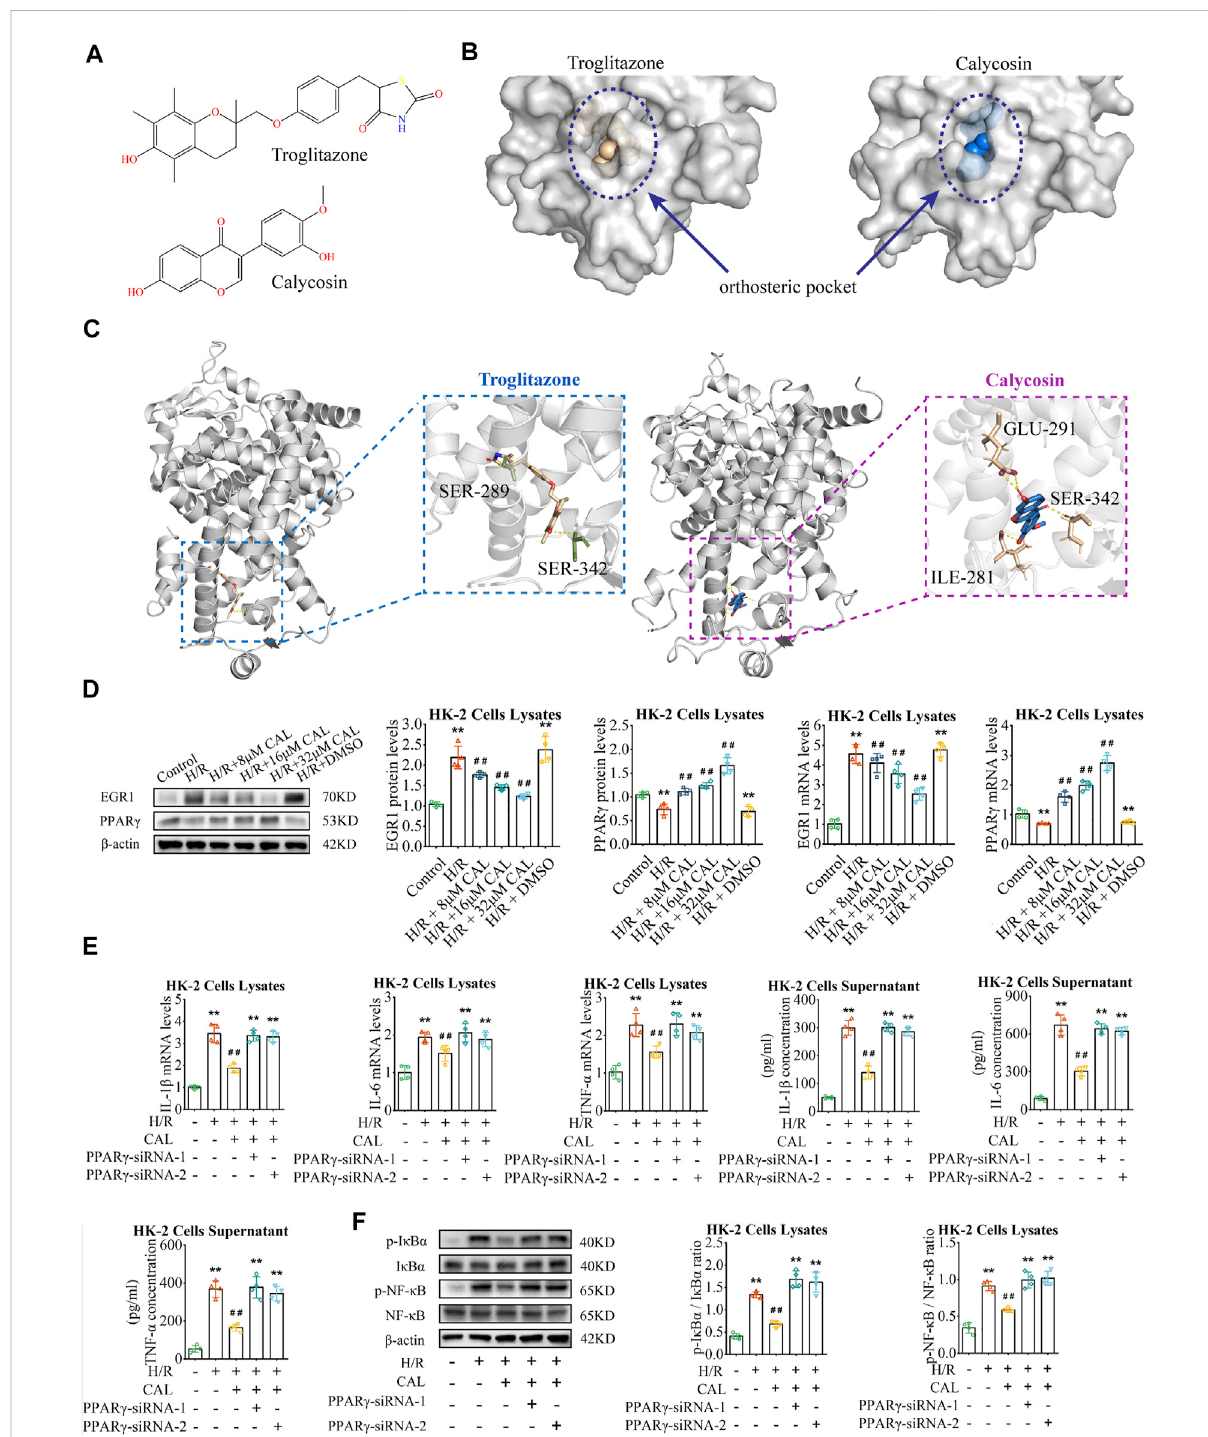
FIGURE 5 CAL inhibited in fl ammation via PPAR γ /EGR1. (A) Chemical structure of troglitazone and CAL. (B) Structure of PPAR γ revealed troglitazone and CAL is located in the orthosteric pocket of PPAR γ . Troglitazone and CAL are shown as the spheres structure, and PPAR γ is shown as the surfaces structure. (C) Troglitazone and CAL (ligand) bound to PPAR γ (receptor) via hydrogen bonds. Ligand are shown as the stick structure, and PPAR γ is shownasthecartoonstructure.Hydrogenbondsareshownasdottedlines(yellow).ILE,isoleucine;SER,serine;GLU,glutamate. (D) ThePPAR γ and EGR1 mRNA and protein levels in different cell groups. (E) IL-1 β , IL-6, and TNF- α mRNA levels in cell lysates and IL-1 β , IL-6, and TNF- α concentrations in supernatant of different groups. (F) The protein levels of p-NF- κ B/NF- κ B and p-I κ B α /I κ B α in cell lysates of different groups. ** p < 0.01 vs. control group. ## p < 0.01 vs. H/R group. n = 4 per group. The data are presented as the mean ±